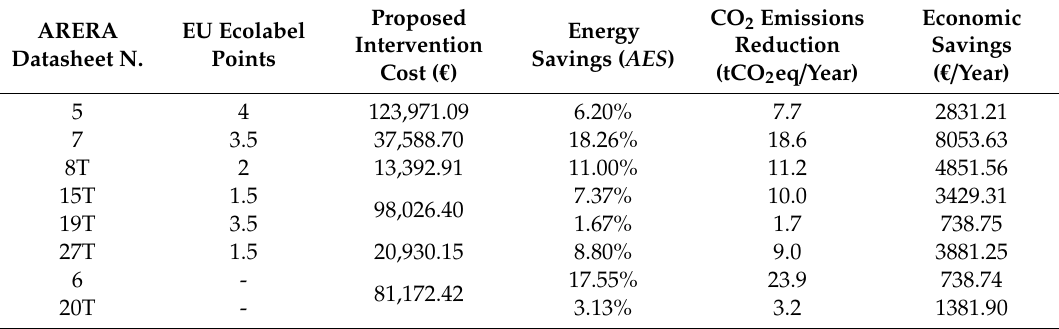
Table 6. Proposed interventions costs and environmental benefits for Bergi agritourism. Proposed ARERA EU Ecolabel Intervention Datasheet N. Points Cost ( €